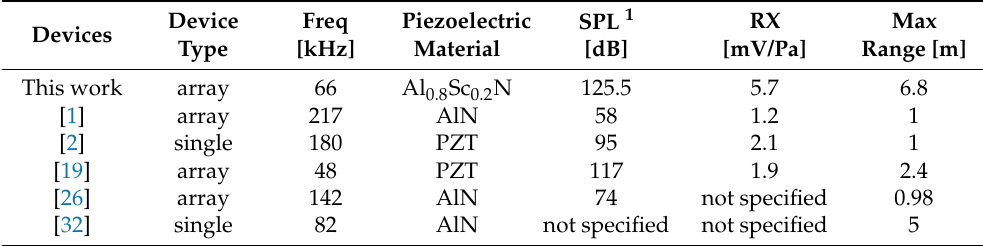
Figure 10. SNR of long-range detection system versus measurement distance. The SNR theoretical model shows the maximum measurement range of the designed device to be 8.4 m at 0% air humidity (good environment, black ) and 6.8 m at 100% air humidity (bad environment, red ). Table 3. Comparison of different PMUT reported before.